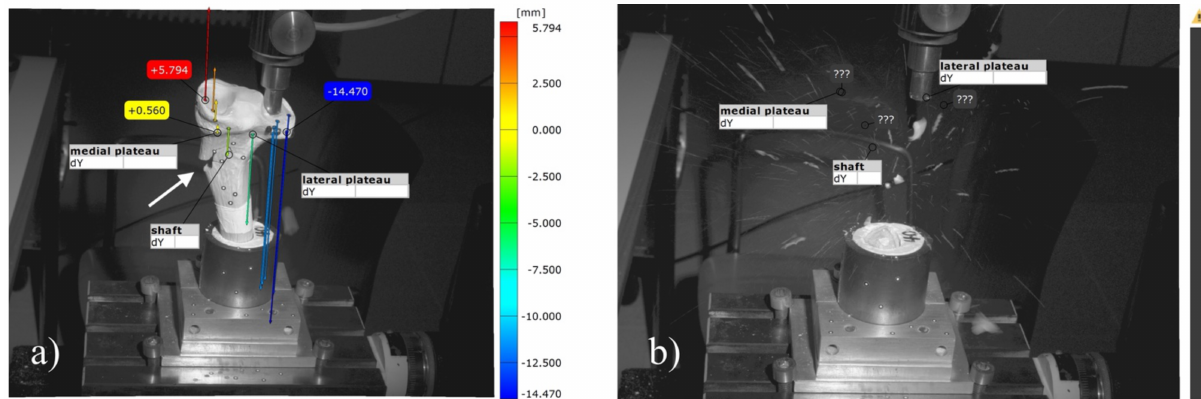
Figure 17. Images of the 3D metrology system of bone no. 40, the bone defect was filled with MPC_22.5 and afterwards four screws in the jail technique were added. The most laterally placed optical reference point is also shown (blue). ( a ) Contrary to the fracture pattern seen in groups without osteosynthesis, a fracture of the medial corticalis at the metaphyseal area occurred during the load to failure (white arrow in a ); ( b ) This was followed by a fracture of the shaft whereas the tibial condyles remained intact. The image was taken at the moment of fracture, when bone debris was flying through the